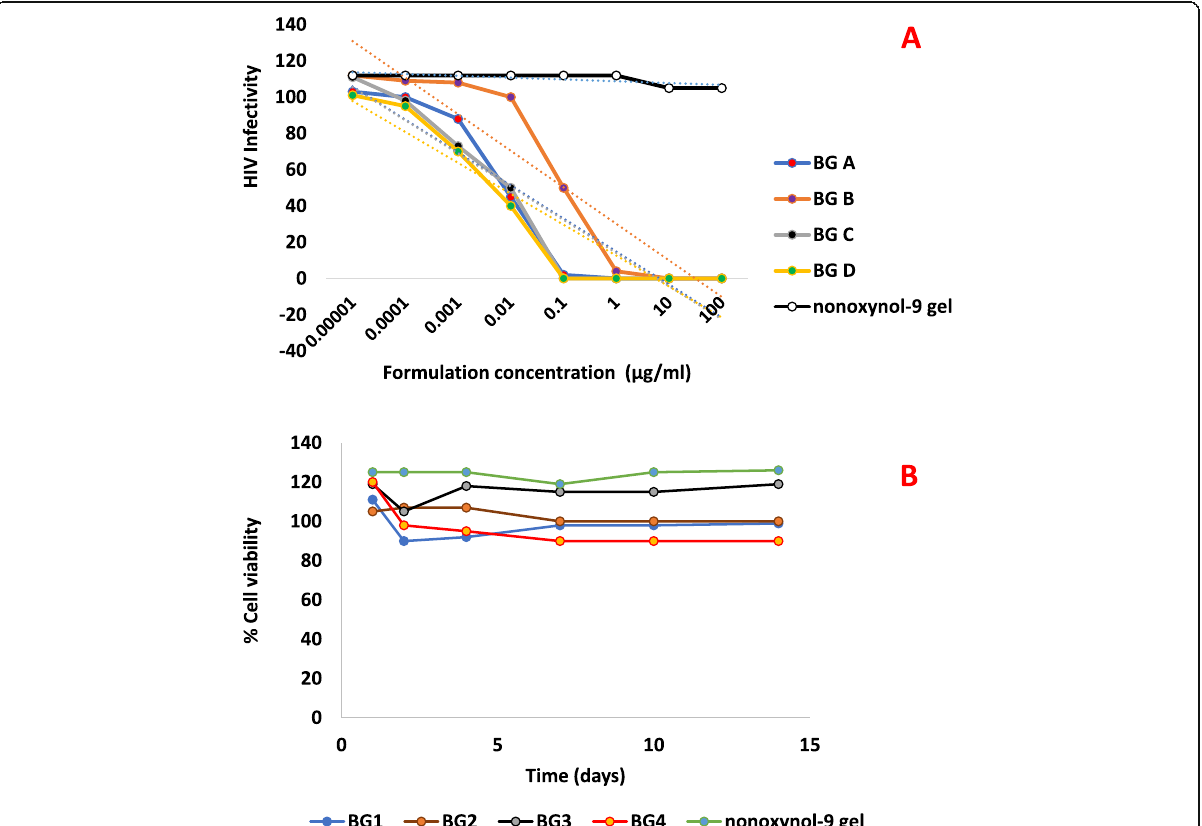
Fig. 4 a HeLa cell cytotoxicity of API from maraviroc tenofovir bigel formulations; results are expressed as % cell viability compared to HeLa cells without any treatment ( n = 3 ± SD). b HIV infectivity dose-response curves for maraviroc from maraviroc tenofovir bigel formulations incubated with HIV-1 indicator TZM-bl cells at different concentrations ( n = 5 ±